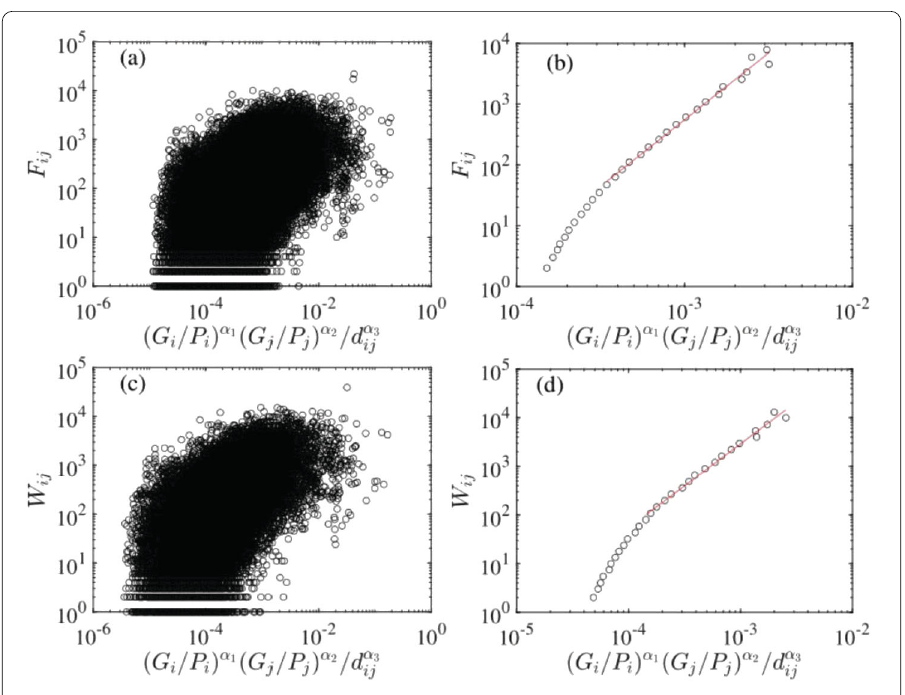
Figure 19 Testing the modified gravity law with population for the directed and undirected freight highway transportation networks constructed over five months. ( a ) Scatter plot of F ij with respect to ( G i / P i ) α 1 ( G j / P j ) α 2 / d α 3 ij for the directed network. ( b ) Binning plot of F ij with respect to ( G i / P i ) α 1 ( G j / P j ) α 2 / d α 3 ij for the directed network. ( c ) Scatter plot of W ij with respect to ( G i / P i ) α 1 ( G j / P j ) α 2 / d α 3 ij for the undirected network. ( d ) Binning plot of W ij with respect to ( G i / P i ) α 1 ( G j / P j ) α 2 / d α 3 ij